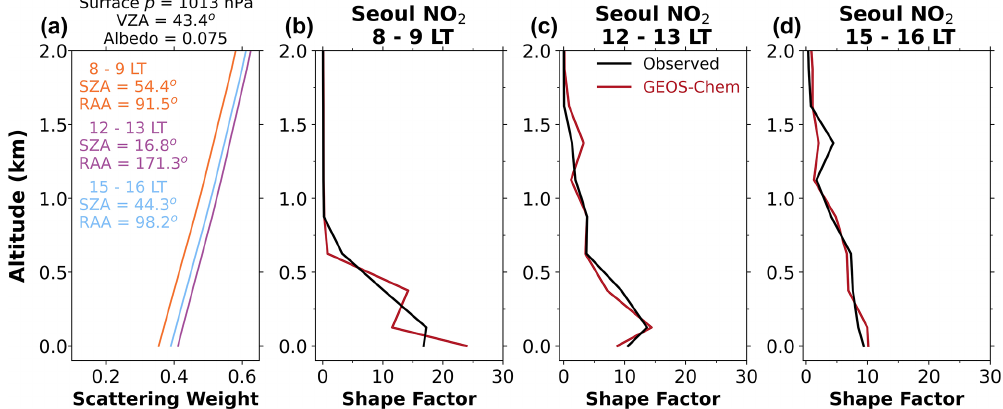
Figure 5. Factors controlling the diurnal variation of the air mass factor (AMF) for GEMS satellite retrieval of tropospheric NO 2 over the SMA. The figure shows clear-sky scattering weights w ( z ) over Olympic Park in the SMA at different times of day with the GEMS viewing geometry (a) and vertical shape factors S ( z ) computed from median vertical profiles of NO 2 number densities at different times of day (a–c) . Observations are from 10 KORUS-AQ flights that repeated the same flight pattern of vertical profiling under clear-sky conditions (4, 7, 17, 18, 30, 31 May; 2, 3, 9, 10 June) at 08:00–09:00 local time (LT), 12:00–13:00LT, and 15:00–16:00LT. SZA and RAA are averaged over the corresponding vertical profiles. The clear-sky scattering weights are taken from the OMI TOMRAD lookup table. The shape factor is extended to the surface by using the surface air NO 2 concentration measured at Olympic Park station. Table 1. Diurnal variation of the air mass factor (AMF) for satellite NO 2 retrievals a . Time of day b SZA RAA AMF